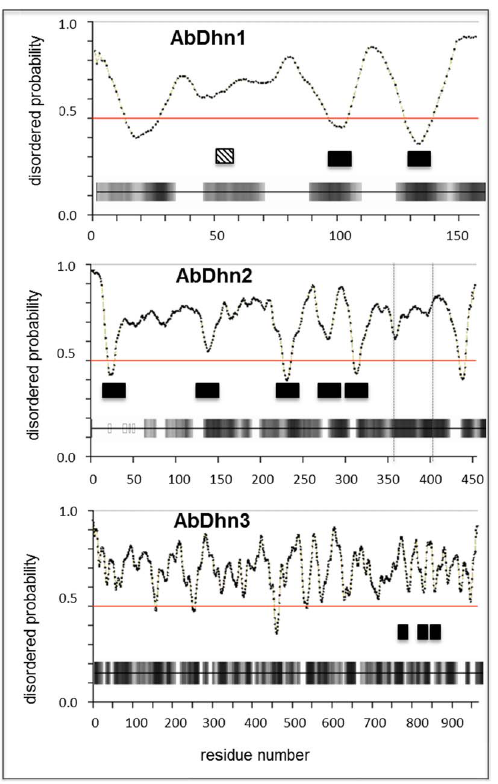
Figure 1. Disorder profiles of the three dehydrin-like proteins from A.brassicicola . Disorder probabilities are plotted according to the residue positions. Residues beyond the red threshold line in these plots are predicted to be disordered. Location of DPR domains (black box) and a predicted TRG_PEX motif (hatched box) are indicated. Predicted binding regions are shown below plots by horizontal bars shaded according to the prediction score. Residues between the vertical dotted lines on the AbDhn2 plot are missing in the ß isoform.